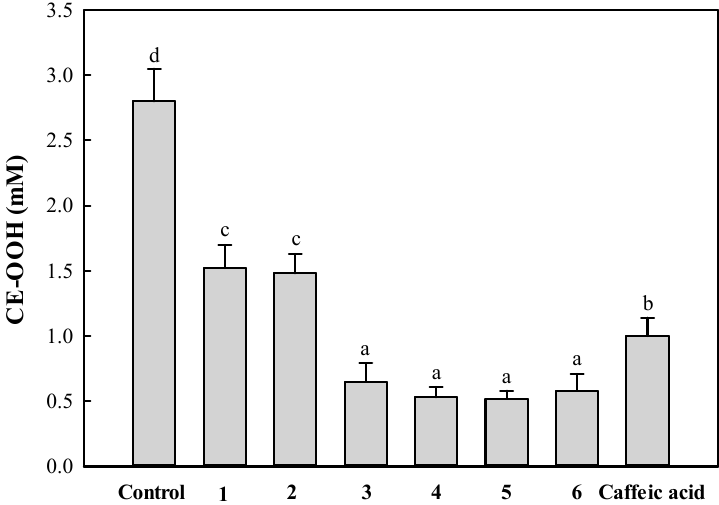
Figure 4. Inhibitory effect against CE-OOH formation by the isolated compounds during copper ion-induced oxidation of diluted rat blood plasma. Rat plasma was diluted four-fold with PBS (pH 7.4) and incubated with 100 μ M CuSO 4 at 37 °C for 7 h. Each compound was added to the rat plasma solution at a final concentration of 10 μ M. Each value is the mean ± SD of three experiments. a–d Results with a different letter differ significantly ( p < 0.05).